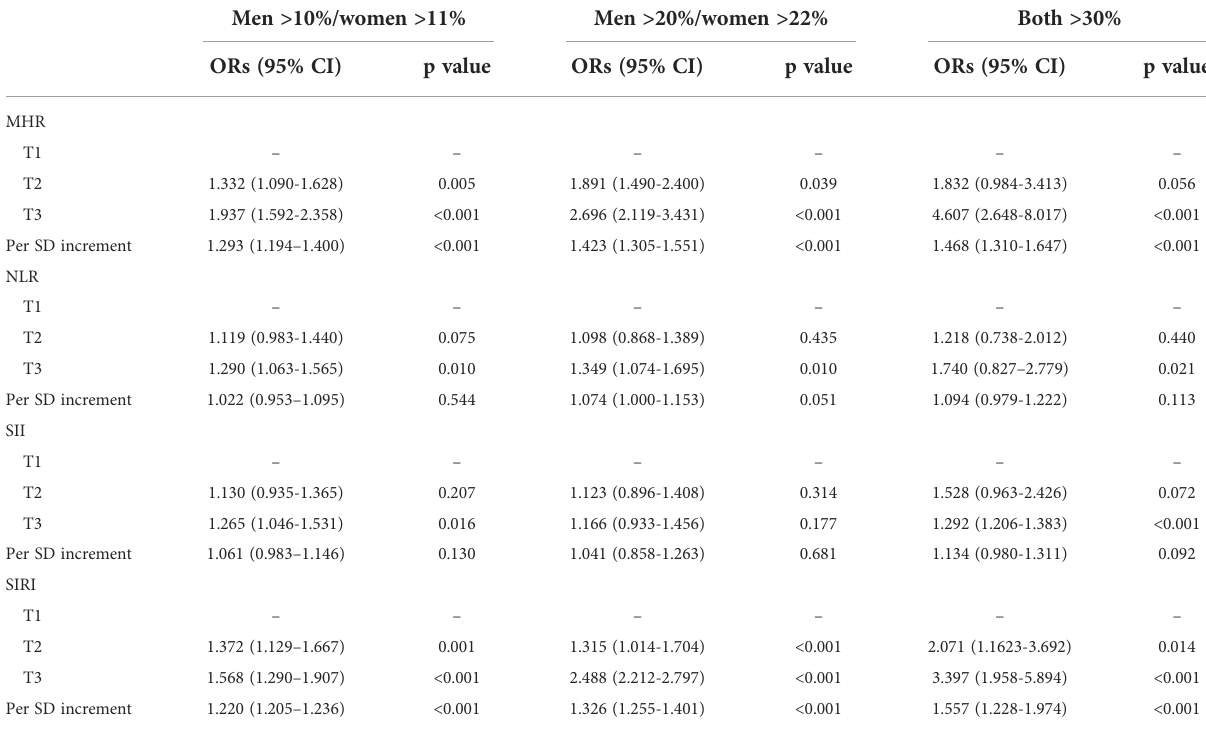
TABLE 6 Chronic in fl ammation status was associated with 10-year CVD